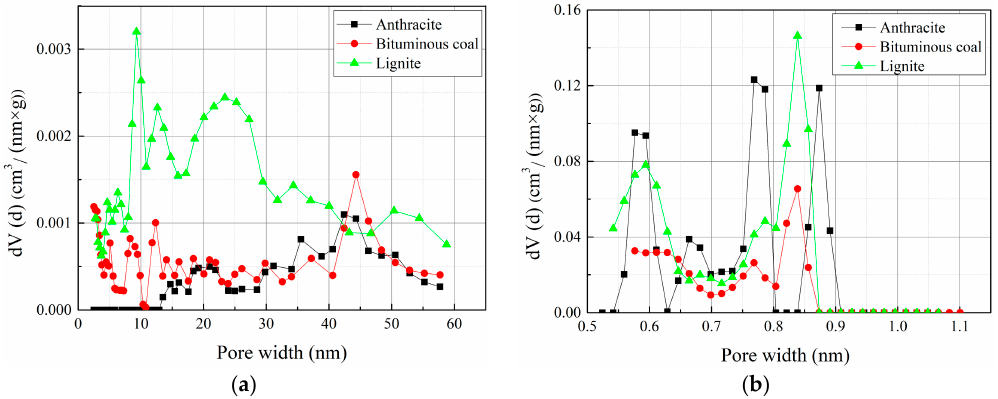
Figure 6. PSD of the coal samples: ( a ) PSD determined by N 2 adsorption; ( b ) PSD determined by CO 2 adsorption.